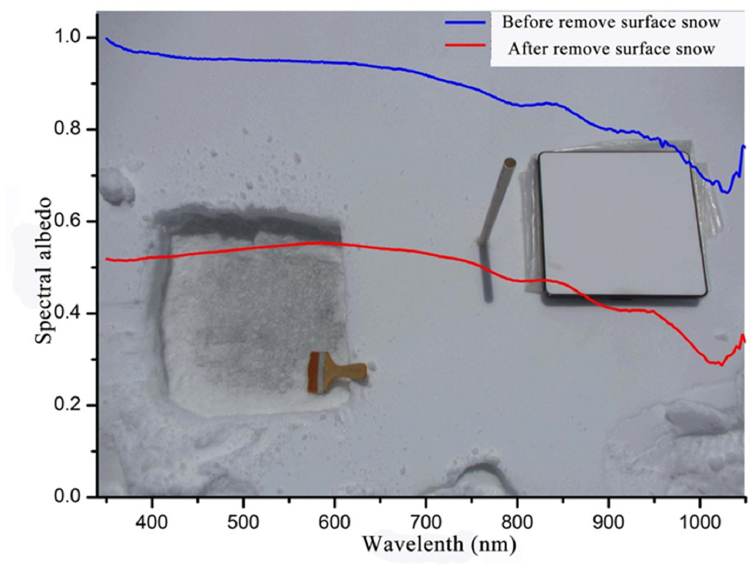
Figure 13. The effect of surface snow on spectral albedo. A comparison of reflectance before and after removal of 9.5 cm of surface snow at point 3 on the QT No. 1 Glacier on 16 June 2015.